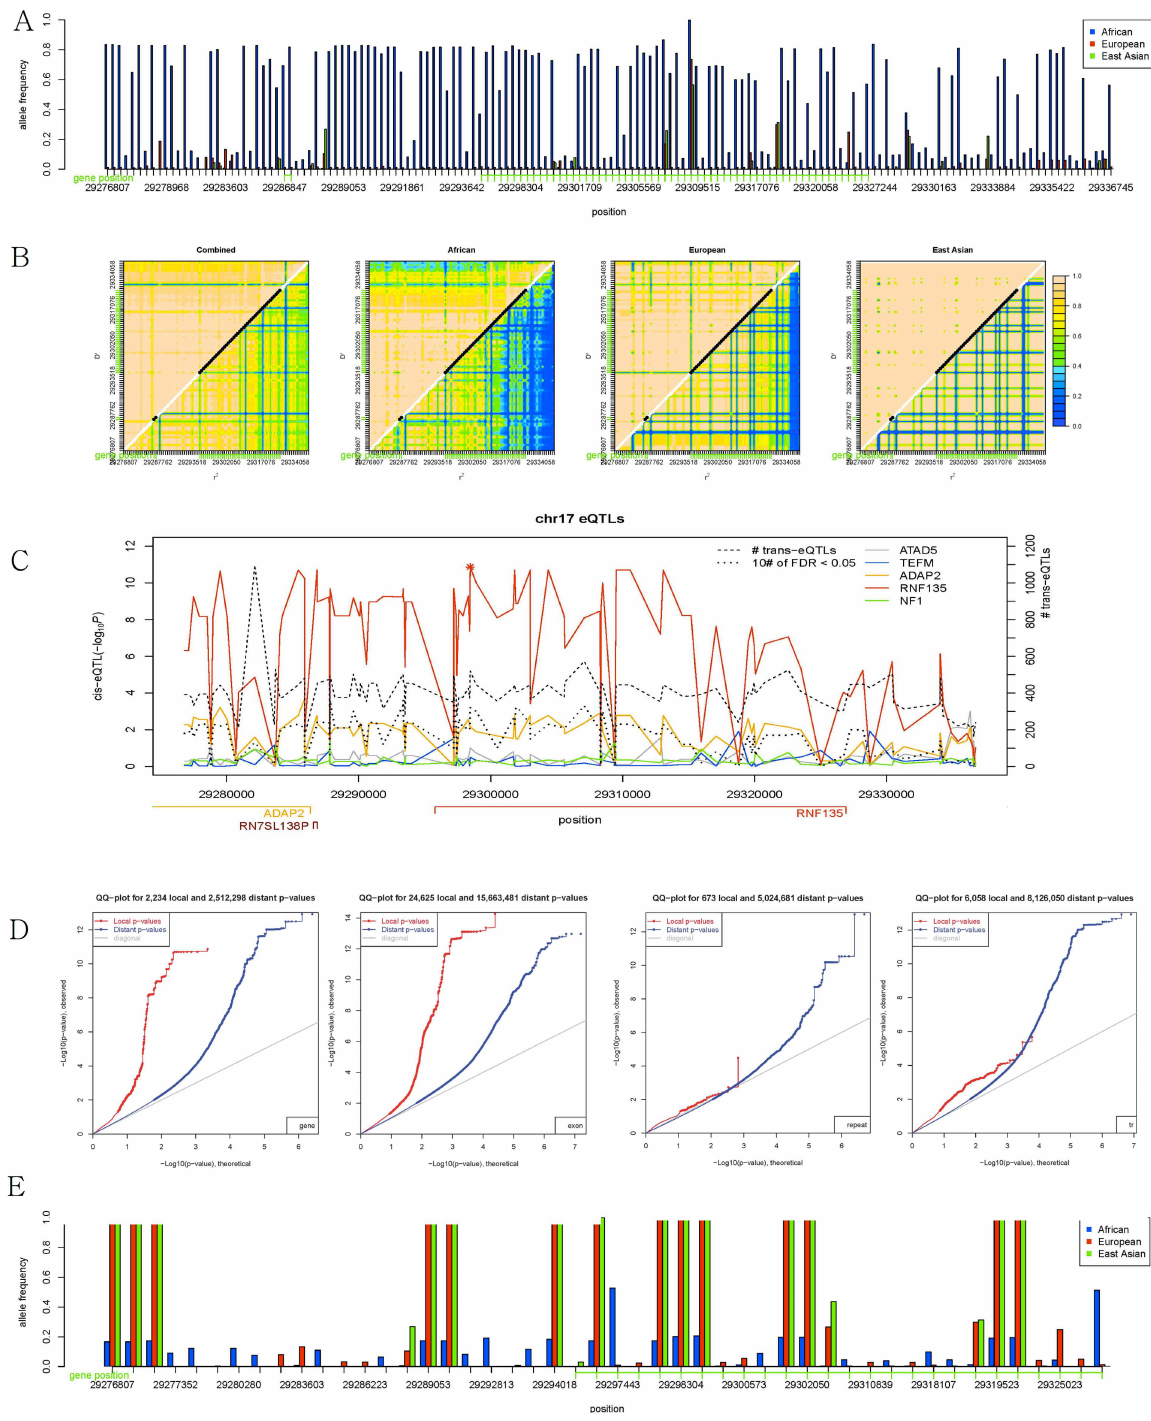
Fig 3. Extendedregions from the population-specific regions betweenAFR and EUR on chromosome 17: (a) Allele frequency distribution; (b) linkagedisequilibrium; (c) expressionQTL; (d) quantile-quantileplot of cis- and trans-eQTL; (e) derived allele frequency